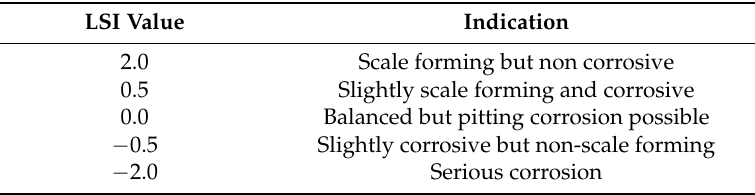
Table 1. Interpretation of the Langelier Saturation Index (LSI) [8].